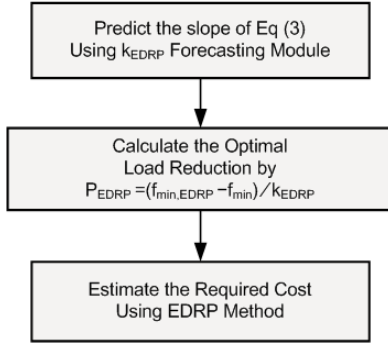
Figure 5. The operation of the EDRP method.